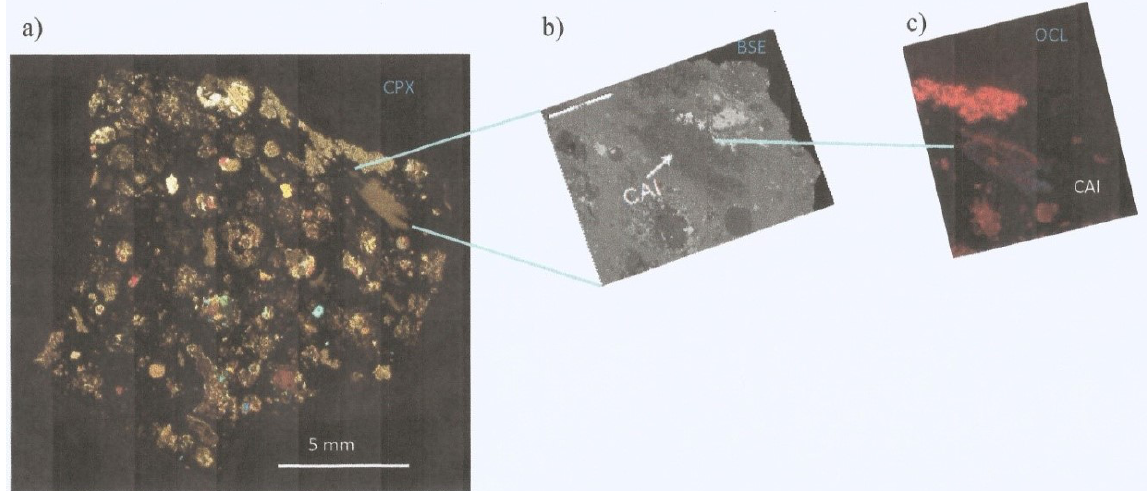
Figure 2. Optical (a), backscattered-electron (b) and optical microsocope-cathodoluminescence (c) show a Calcium-Aluminium inclusion in Kaba meteorite. An optical microscope-cathodoluminescence image shows a homogeneous distribution of cathodoluminescence red and blue color arranged in a zoning pattern.